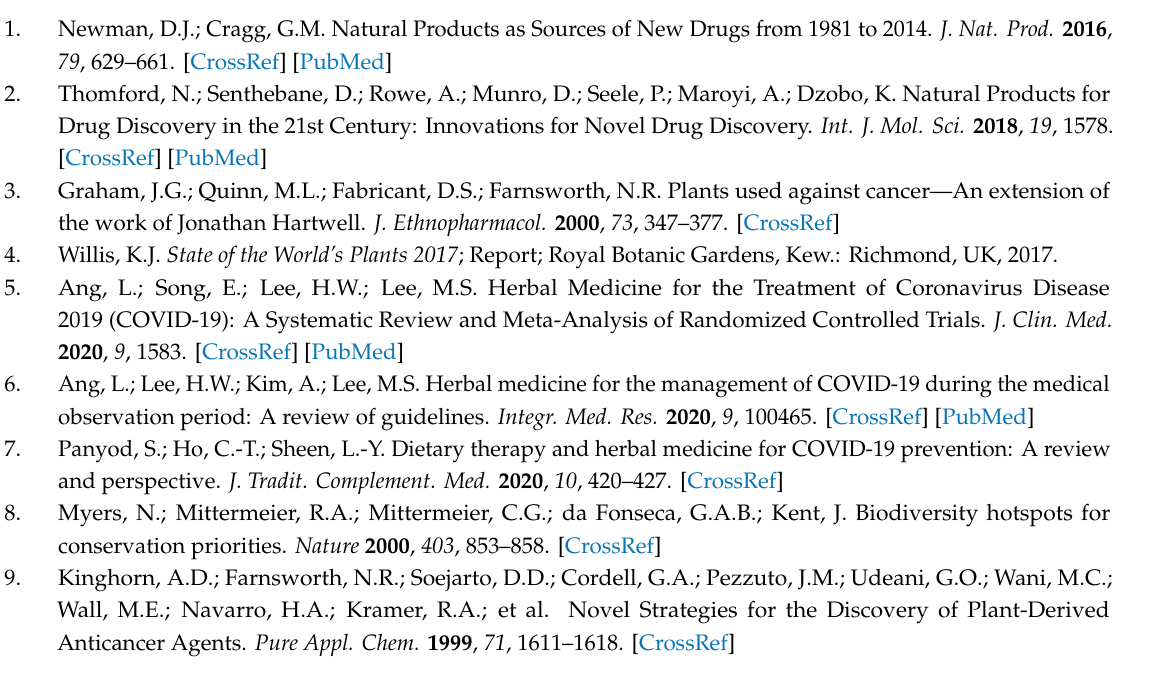
s1, Figure S1: Cell viability profile of HepG2 cells treated with T. bentzoë extract and fractions. Figure S2: Representatives annexin V-FITC / PI flow cytometric profile of HepG2 cells, 48 h post-extract / control treatment. Figure S3: Representatives cell cycle histogram of HepG2 cells, 48 h post-extract / control treatment. Figure S4: UPLC ESI MS of the butanol fraction 6 at the positive (A) and negative (B) mode. Figure S5: 1 H NMR spectrum (A) and HSQC spectrum (B) for punicalagin (1) in an HPLC fraction at RT 2-3 min in methanol-d 4 . Figure S6: 1 H NMR spectra for a mixture of isoterchebulin (2), terflavin A (3), and 3,4,6-trigalloyl-beta-D-glucopyranose (4) in a HPLC fraction at RT 18-20 min in acetone-d 6 (A) and methanol-d 4 (B). Figure S7: 1 H NMR spectra for a mixture of 2”- O -galloyl-orientin (3) and 2”- O -galloyl-isoorientin (6) with a ratio of 5:2 based on the integration of single hydrogen in each compound. Figure S8: GC-MS chromatogram of TMSi derivatives of ethyl acetate (A) and butanol (B) fraction of T. bentzoë . Table S1 1 H NMR spectral data (500 MHz, CD 3 OD) of the O -galloyl-C-glycosylflavones 7 and 8